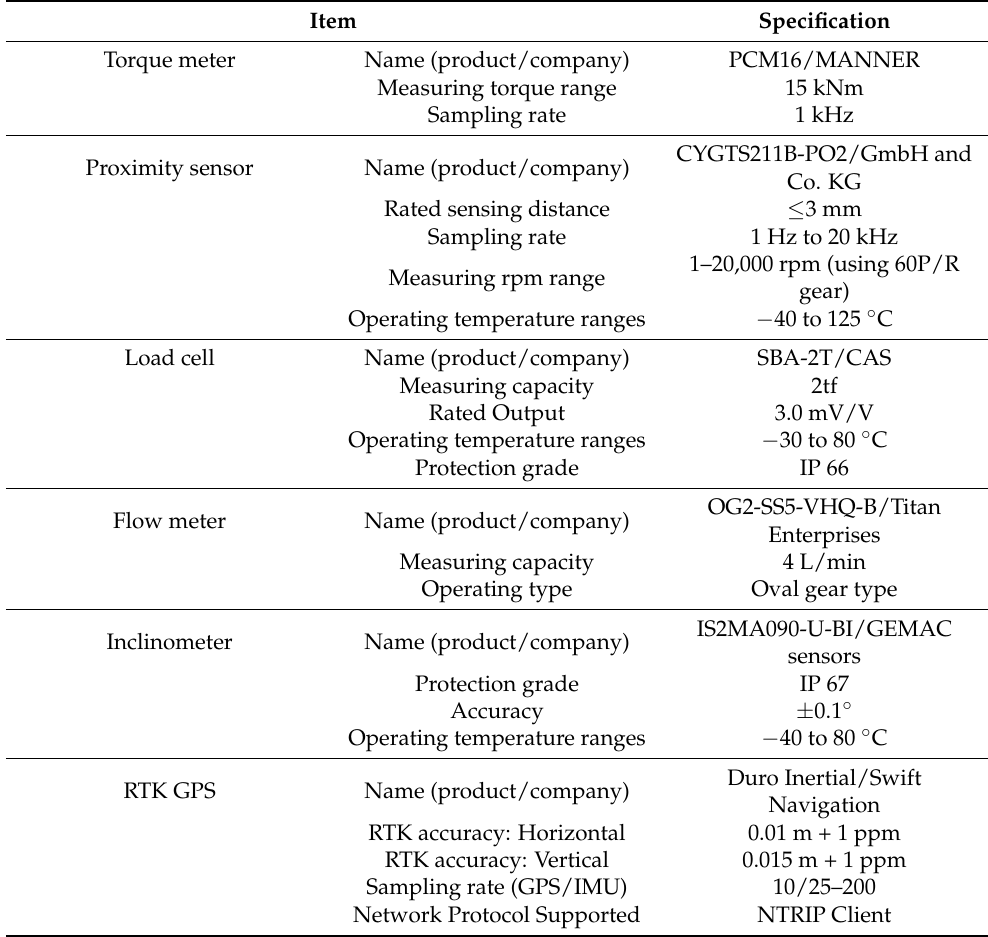
Table 3. Specification of the sensors constituting the field load measurement